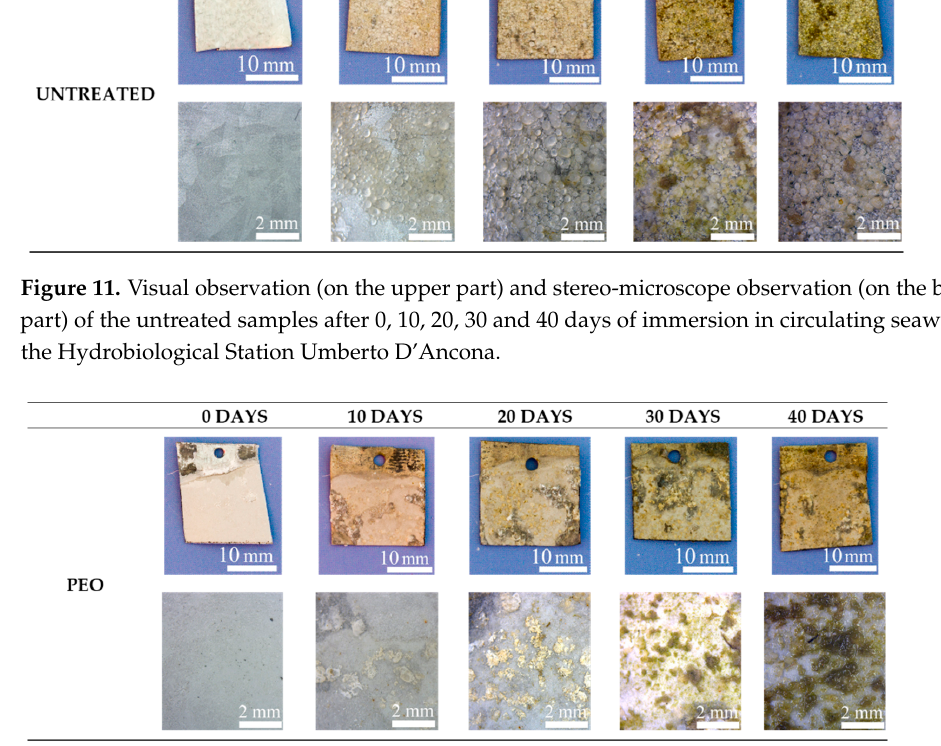
Figure 12. Visual observation (on the upper part) and stereo-microscope observation (on the bottom part) of the PEO treated samples (1A UP No part) samples after 0, 10, 20, 30 and 40 days of immersion in circulating seawater at the Umberto D’Ancona Hydrobiological Station.